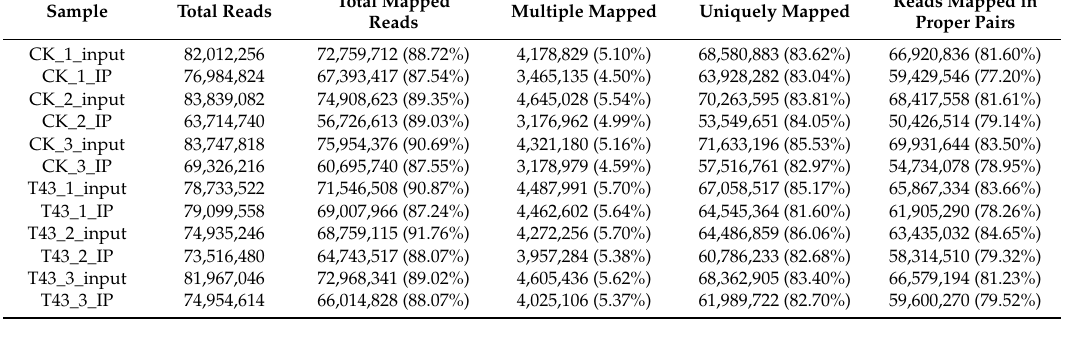
Table 2. Read alignment statistics.